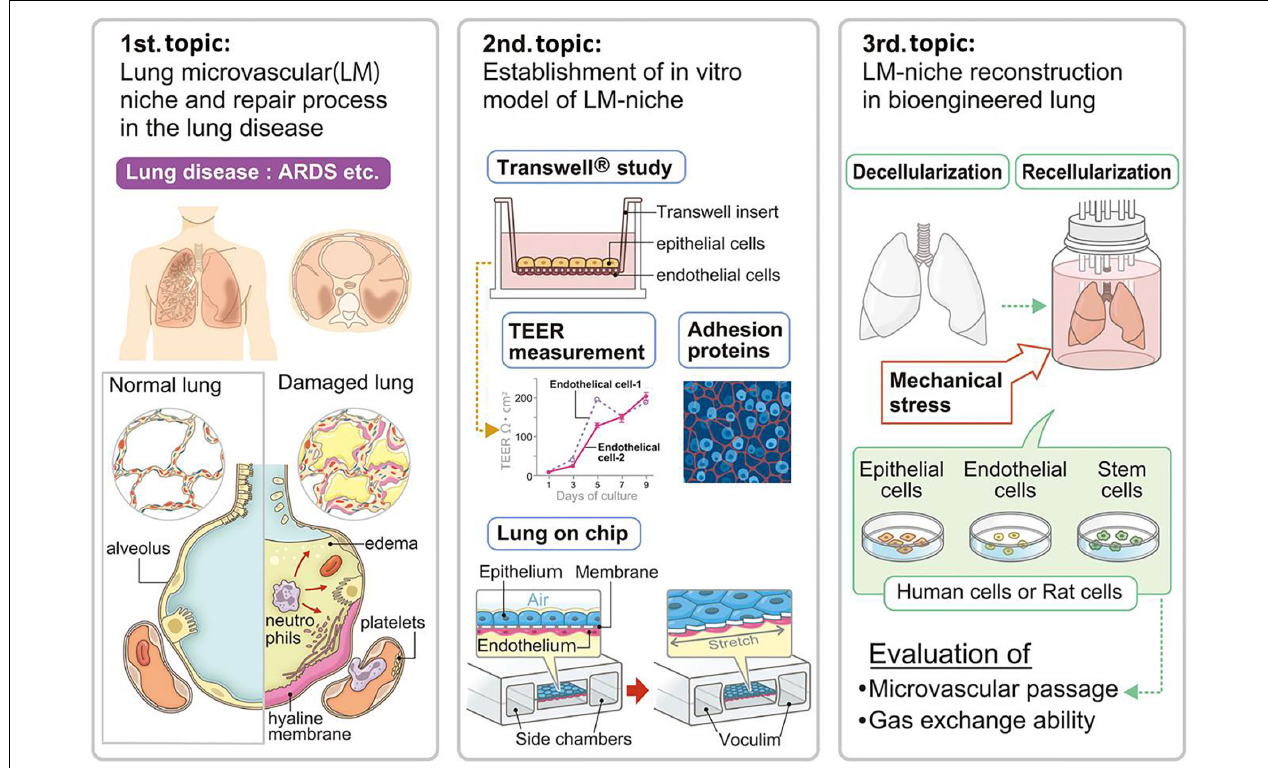
FIGURE 1 | Advancements in lung microvascular niche reconstruction. The lung microvascular niche has been studied in the pathologies of lung disease and animal experimental models. Lung capillary mimics including Transwell R (cid:13) and lung-on-a-chip have been developed by researchers for understanding and simulating the lung microvascular niche. The cell replacement technique for whole lung organ engineering consequently needs to establish a microvascular niche in the natural scaffold. Suitable combination and numbers of cells with ideal mechanical stress will be necessary for whole lung organ engineering, which will be evaluated by microvascular passage, microvascular leakage, and gas exchange ability. ARDS, acute respiratory distress syndrome; TEER, trans-epithelial electrical